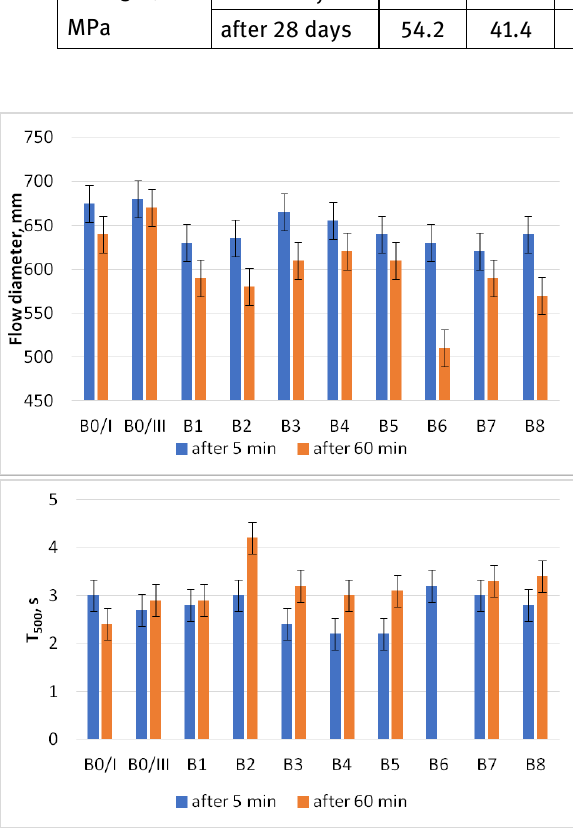
Figure 2: The influence of the cement type on slump flow and flow time of the fresh SCC.